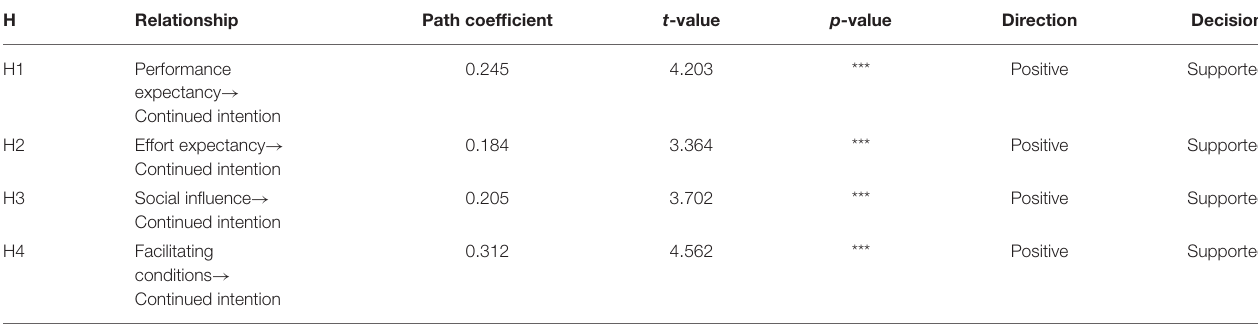
TABLE 6 | Structural equation modeling (SEM) results.